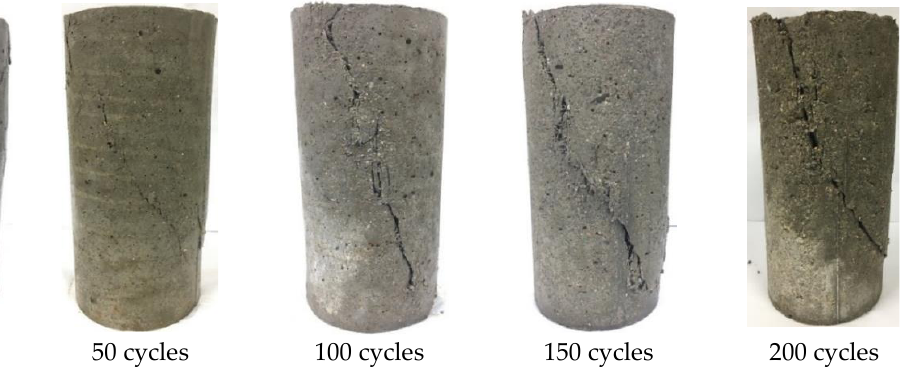
Figure 14. Failure mode of SF10 specimens with 5 MPa confining pressure under different numbers of F-T cycles.